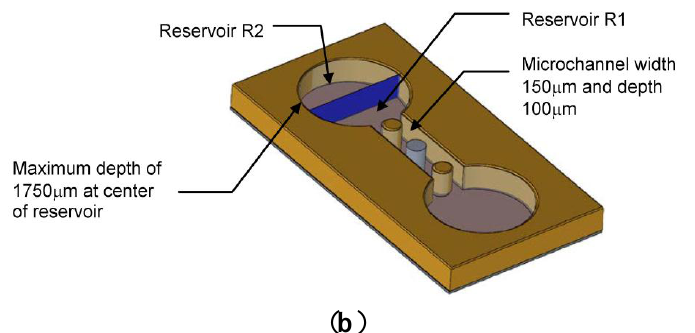
Figure 4. The components and assembly of the microfluidic chip used in this study. Note that the bR-PAA transducer is inserted perpendicular to the flow channel. ( a ) Individual components of the experimental PDMS microfluidic chip with two identical semi-spherical 3500 μm diameter reservoirs. ( b ) Assembled device and key dimensions. Note that the transducer divides one of the dominant reservoirs into two equal sections R1 and R2.